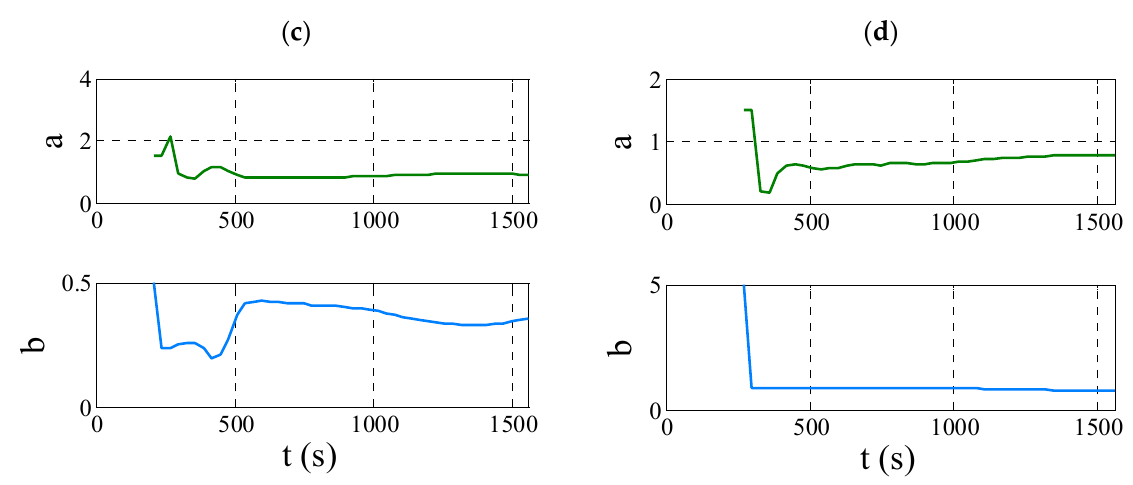
Figure 7. Parameters of dynamic models with step responses as in Figure 6 estimated by the Kalman filter method for delay times ( a ) 120 s, ( b ) 150 s, ( c ) 210 s, and ( d ) 270 s.